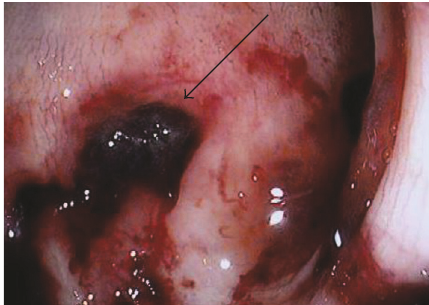
Figure 4: Endoscopic image of the descending colon with mucosal hemorrhage and a large actively bleeding